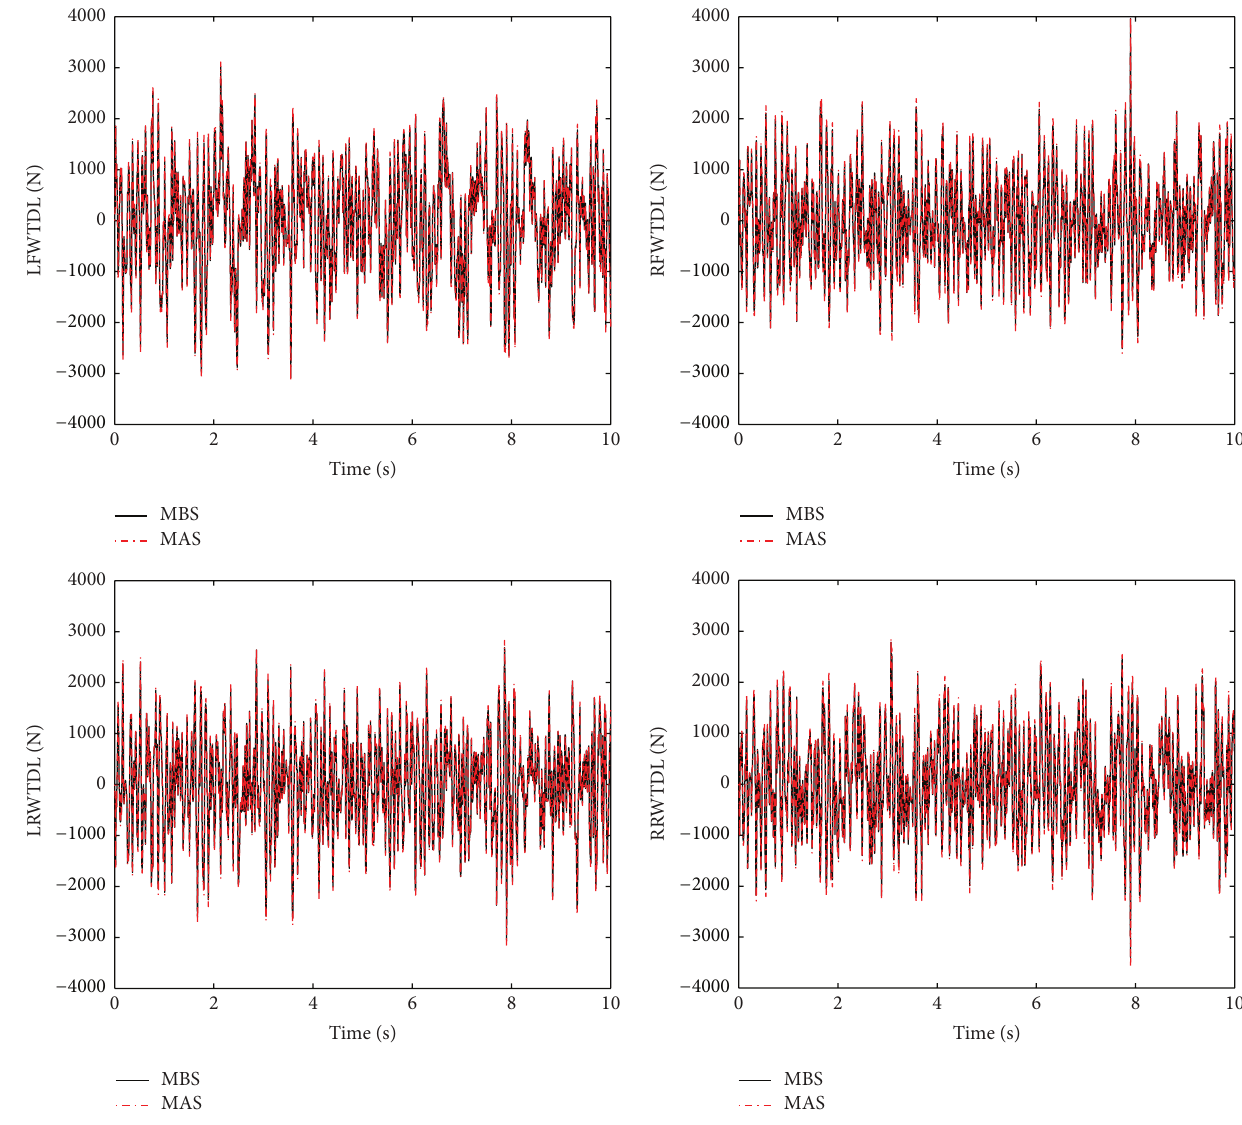
Figure 9: Contrast results of the tire dynamic loads.